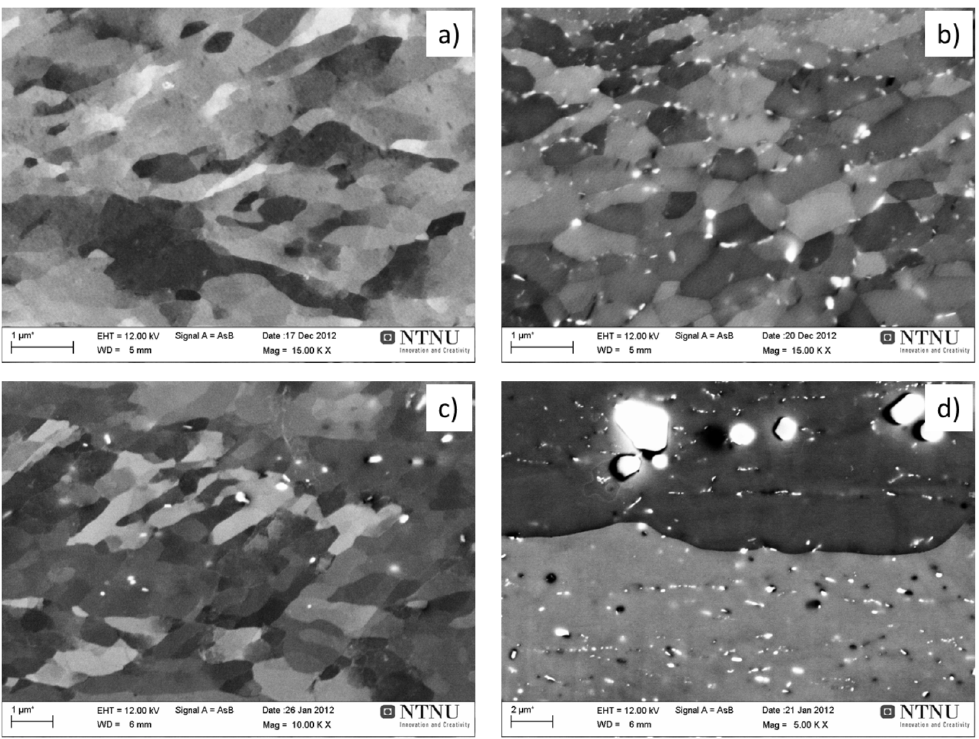
Figure 7. SEM ‐ BSE images exemplifying of the microstructure and dispersoid structure evolution during different annealing times at 350 °C for the C2 ‐ 0 and C2 ‐ 1 materials, respectively, after strain of ε = 1.6: ( a ) C2 ‐ 0, annealing of 5 s; ( b ) C2 ‐ 0, annealing of 10 4 s; ( c ) C2 ‐ 1, annealing of 5 s; and ( d ) * C2 ‐ 1, annealing of 10 4 s. * [30] Copyright 2012 by The Minerals, Metals and Materials Society, reprinted with permission.